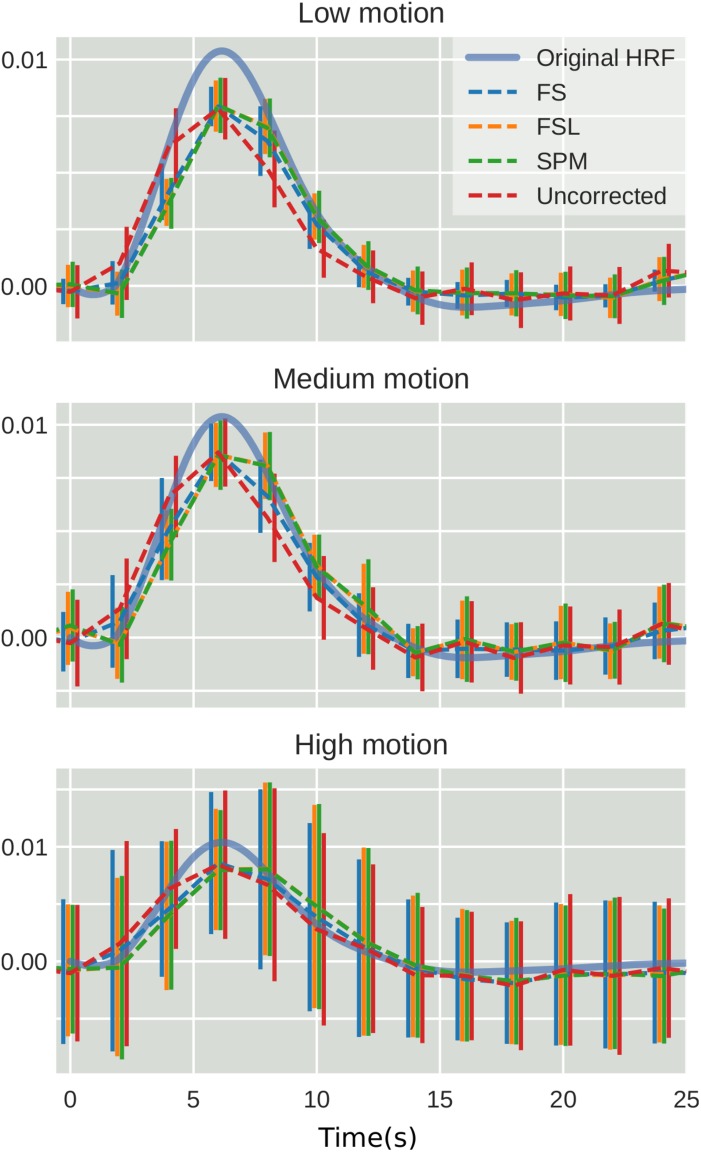
The effect of STC on the accuracy of BOLD response. Normalized HRF’s extracted from the top 20 voxels identified using the shifted regressor method for low, medium, and high motion in simulated data. HRF’s were extracted using FIR deconvolution for each STC method (dashed lines). The reference HRF used in the simulation is plotted as a solid blue line. For each motion level and STC method, HRF’s are combined across all pipeline orders.